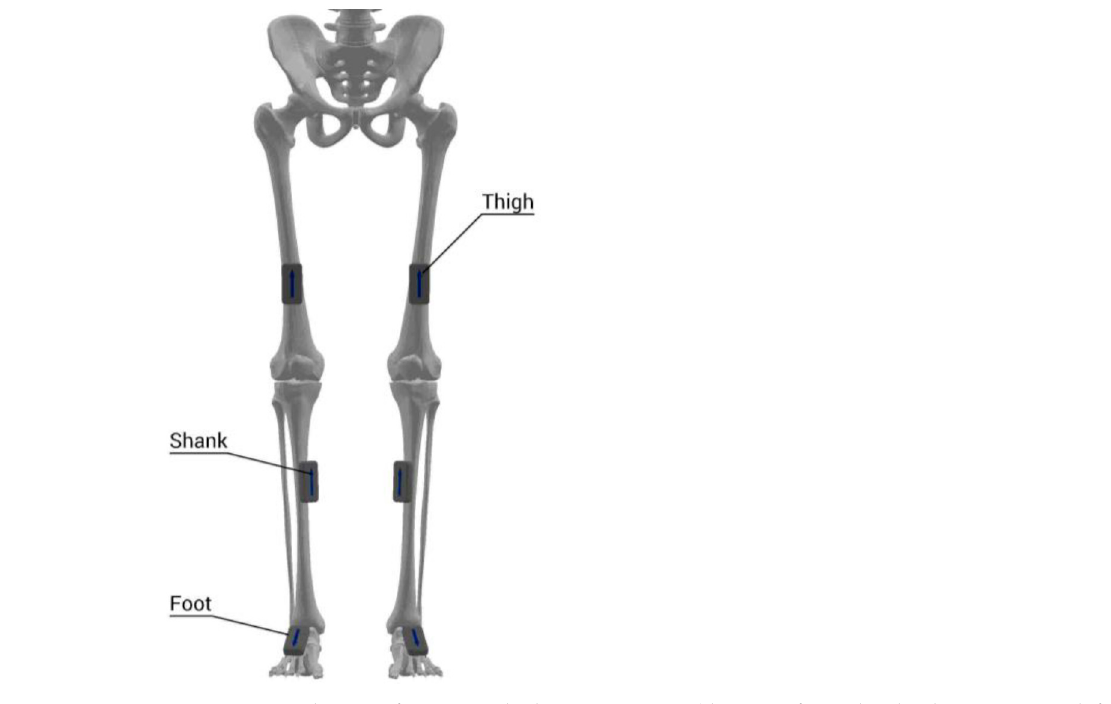
Figure 2. Attachment of IMUs on the lower extremity (the axis of angular displacement was defined to be the same as the axis of angular displacement of the Mocap-based coordination system) using MR3 3.16.